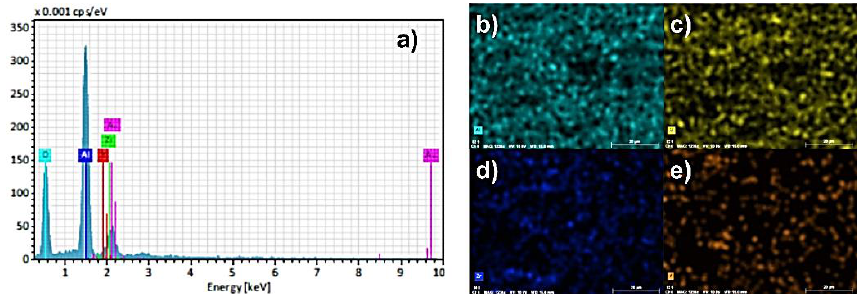
Figure 11. ( a ) EDS spectra of surface fracture of Al 2 O 3 –ZrO 2 ceramics with 10 wt. % of ZrO 2 and corresponding element mappings: ( b ) Aluminum (Al); ( c ) Oxygen (O); ( d ) Zirconium (Zr); ( e ) Yttrium (Y).